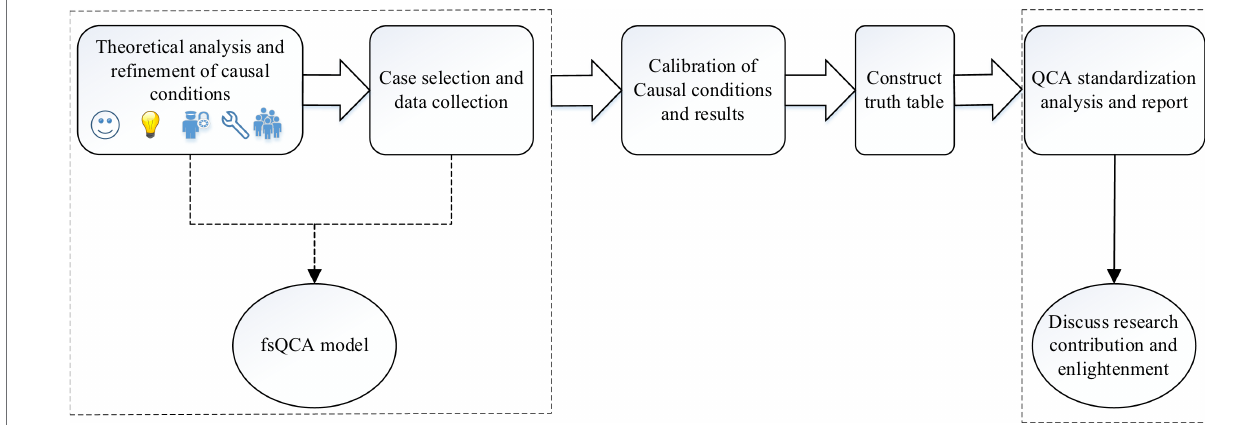
FIGURE 3 | The main steps of fsQCA